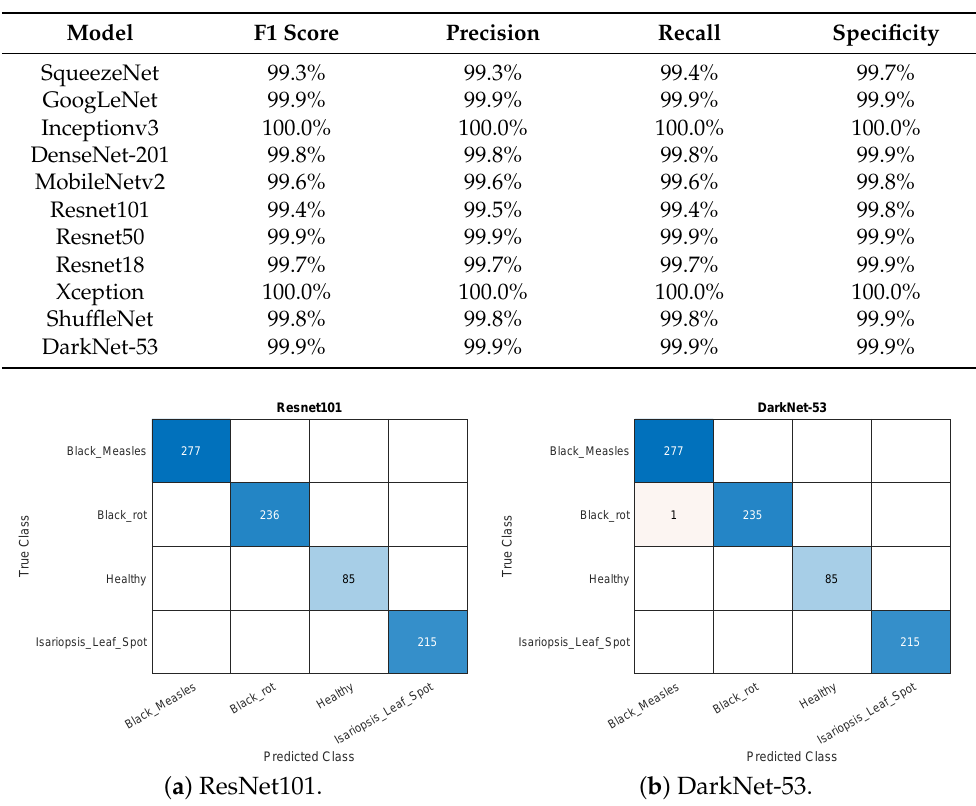
Table 4. Results for the performance evaluation metrics using 80% of the data for training. Numbers represent mean overall values over 10 runs.